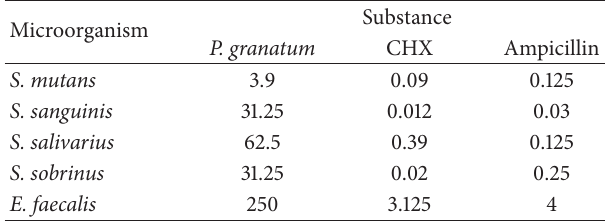
Table 3: The MBC (mg/mL) of hydroalcoholic extract of P. grana- tum petal, CHX, and Ampicillin for different